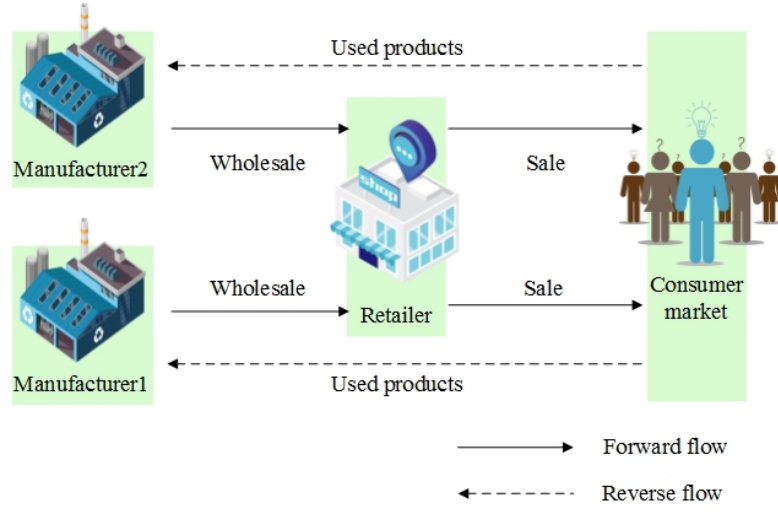
Figure 1. Decentralized model with manufacturer